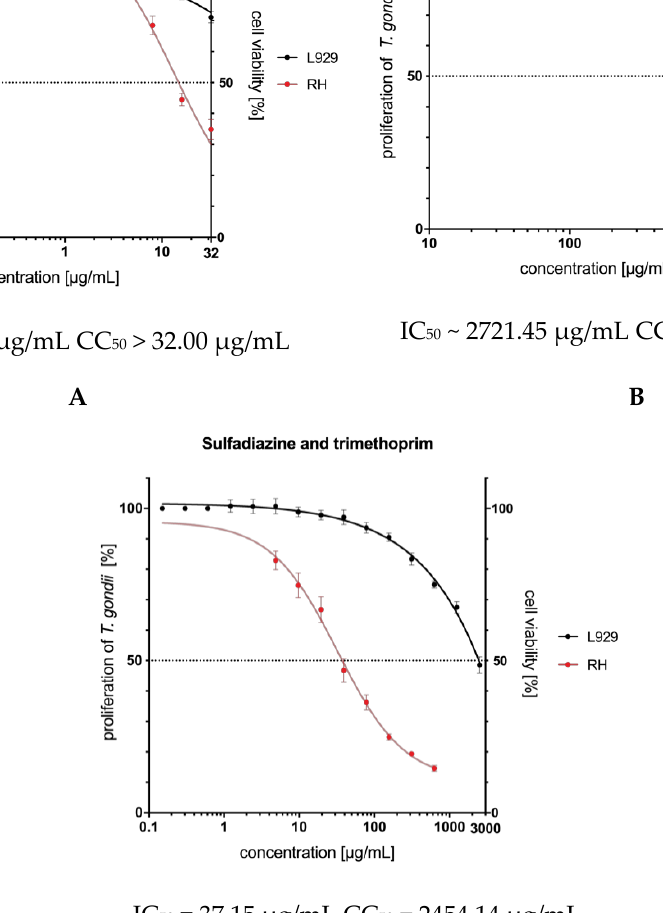
Figure 2. Presentation of the inhibitory concentration (IC 50 —proliferation of Toxoplasma gondii ), cytotoxic concentration (CC 50 —cell viability) and selectivity ratio of ( A ) sulfadiazine, ( B ) trimethoprim and ( C ) combination of sulfadiazine and trimethoprim (5:1) against Toxoplasma gondii .